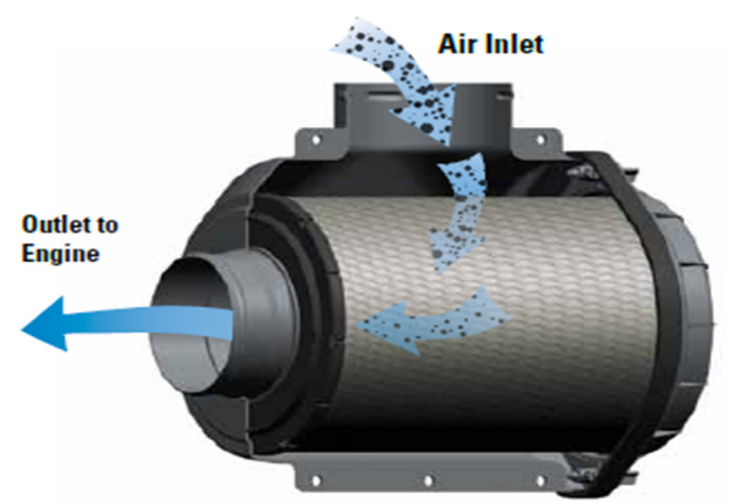
Figure 1. Air purification mechanism of one-stage air cleaner [7].